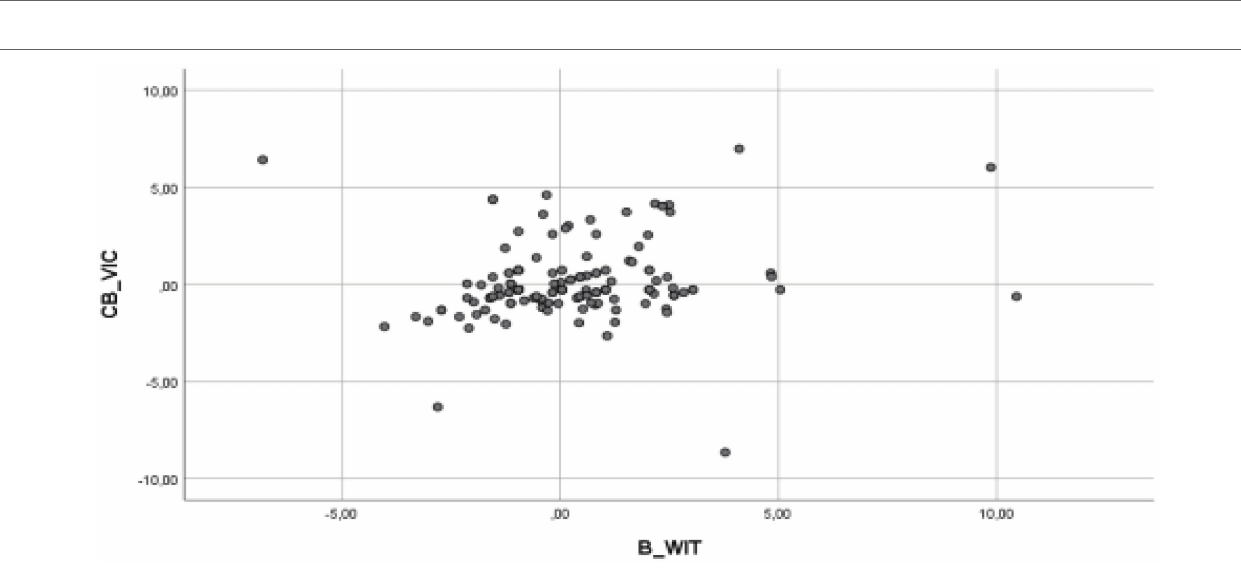
FIGURE 5 | Partial regression graphs of the cyberbullying role of victims criterion variable (CB_VIC), with the predictive variable the role of harassment of witnesses (B_WIT), included in the model.